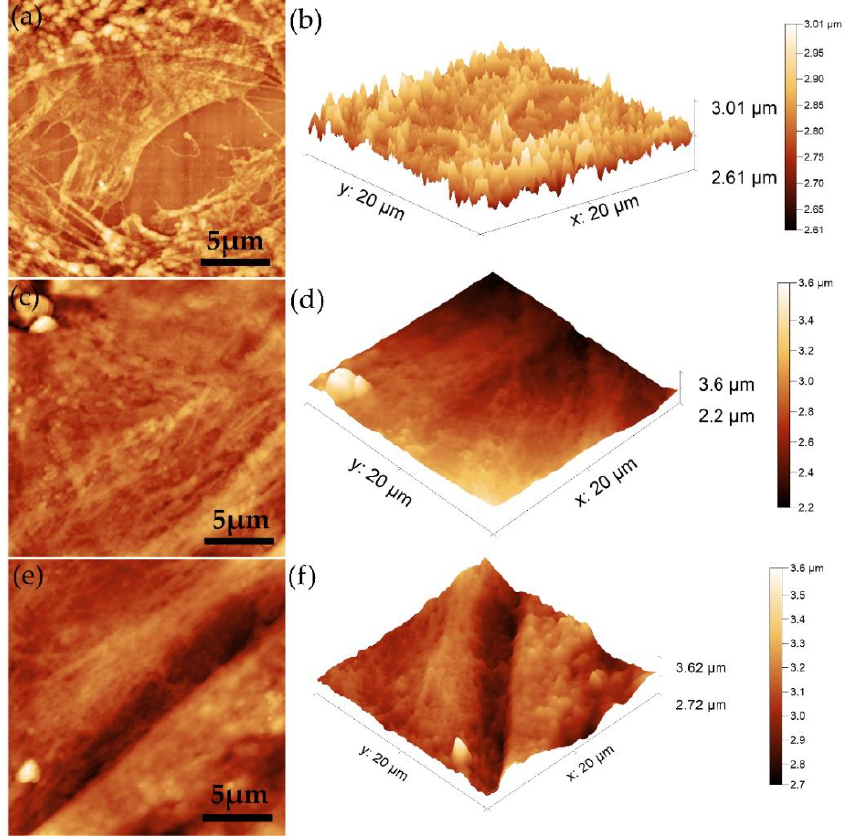
Figure 14. 2D AFM topography of gingival fibroblasts after 24 h of incubation with uncoated Si substrates ( a ), 5CeHAp-D composite thin film ( c ) and 10CeHAp-D composite thin film ( e ) and their 3D representation ( b , d , f ).